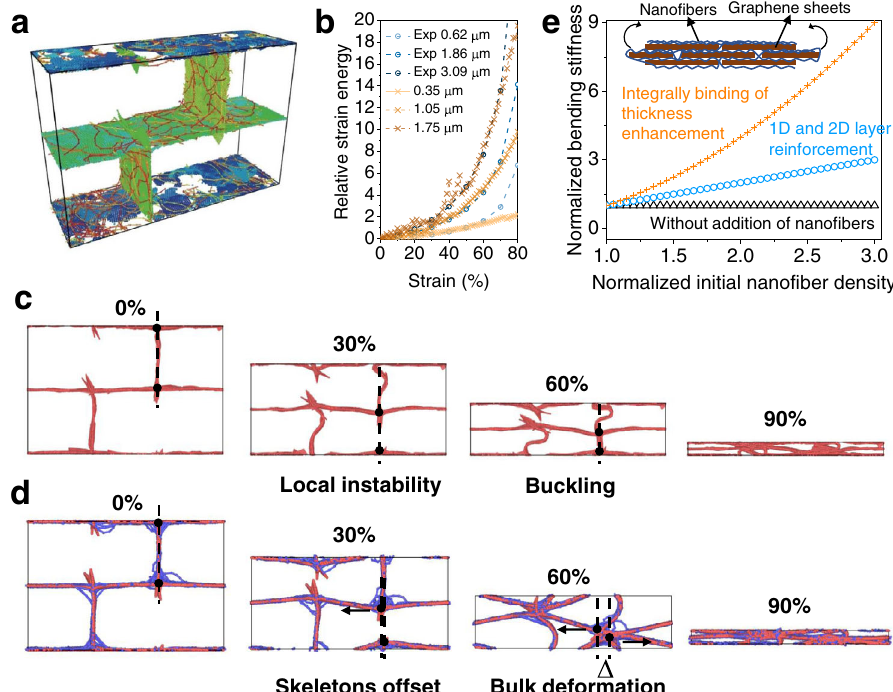
Fig.5|Moleculardynamicsimulationsofstrengthenmechanism.a Calculation model,wheredifferent graphenesheets and fi bers aremarkedindifferentcolors. b Relative strain energy versus strain, where three experimental samples with typical thicknesses of 0.62, 1.86 and 3.09 μ m, are compared with the simulation resultswiththeirskeletonthicknesses(0.35,1.05,1.75 μ m).Forexperimentaldata, the strain energy under 50% compression with typical thicknesses of 0.62 μ m is chosen to normalize strain energy, and correspondingly the strain energy under 50%compressionwith skeleton thickness of0.35 μ m forsimulation results. c The simulationdeformationprocessofPGA. d Thesimulationdeformationprocessof